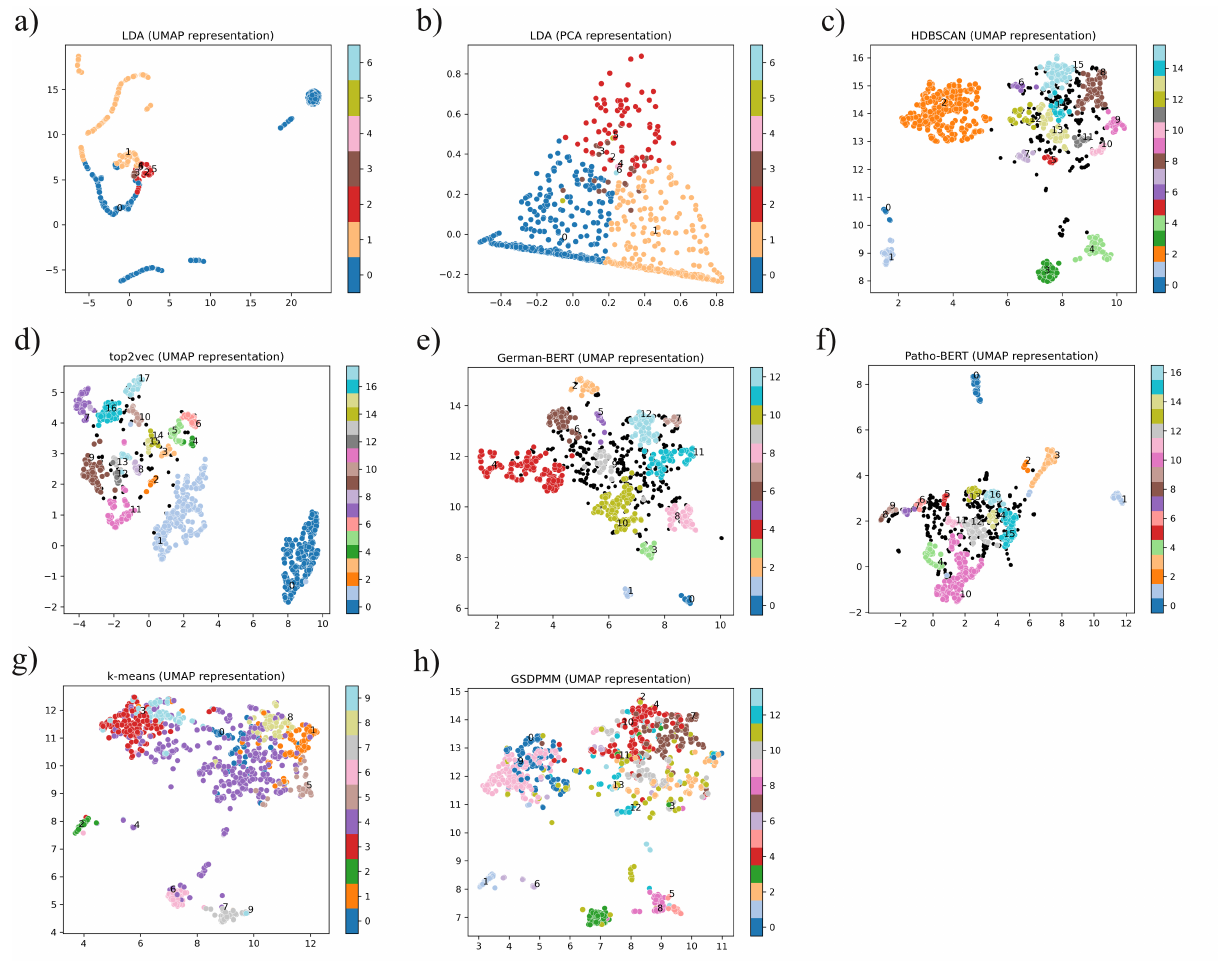
Figure 2. UMAP! ( UMAP! ) and PCA! ( PCA! ) of different cluster-sets. UMAP representations of the cluster-sets generated with ( a ) LDA! ( LDA! ), ( c ) HDBSCAN! ( HDBSCAN! ), ( d ) top2vec, ( e ) German-BERT, ( f ) Patho-BERT, ( g ) k-means and ( h ) GSDPMM! ( GSDPMM! ). The LDA! cluster- set is also shown as PCA! ( PCA! ) in ( b ). Each data point represents a diagnosis section of a report. The data points are coloured according to the respective clusters. Black points represent outliers that were not assigned to any cluster. Above all, the clusters of top2vec and HDBSCAN! appear particularly tidy and separated. The clusters of k-means and GSDPMM! appear less well separated, which is probably also due to the fact that no data points are sorted out